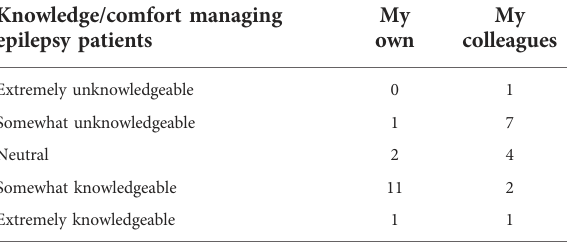
TABLE 8 Providers self-ratings and ratings of colleagues. Knowledge/comfort managing epilepsy patients